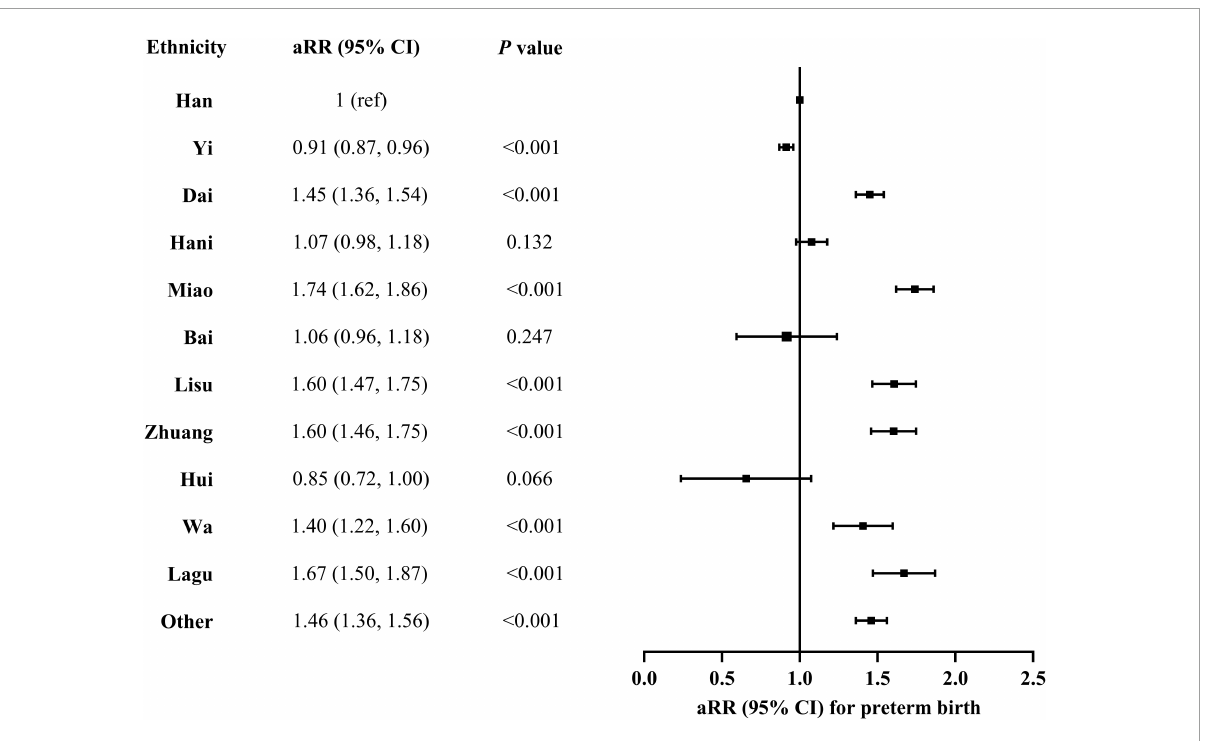
FIGURE4 Association between preterm birth and maternal ethnicity in rural Yunnan, Southwest China, 2014–2018. aRR, adjusted risk ratio. A multivariable log-binominal regression model was conducted with adjustment for year of delivery, maternal age at delivery, education, occupation, pre-pregnancy, history of chronic disease, history of preterm birth, smoking and drinking alcohol during early pregnancy, and parity and multiple pregnancy of current